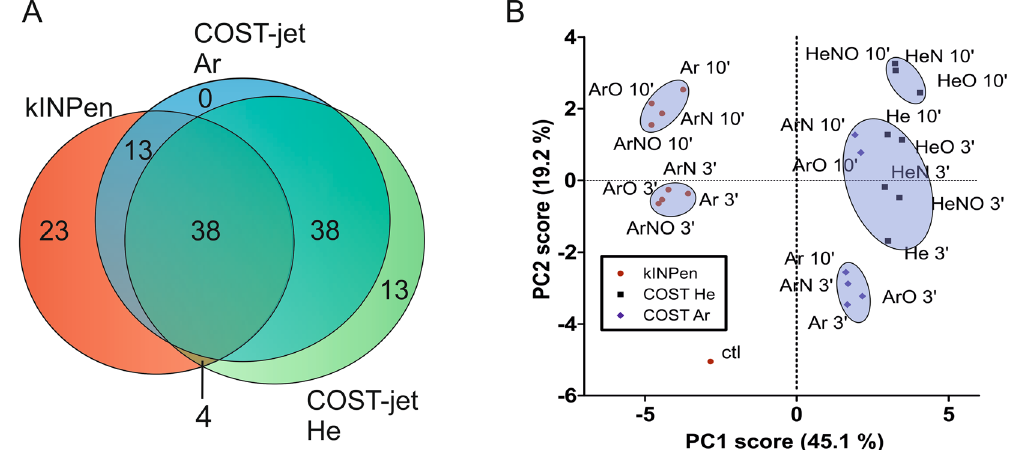
Figure 4. Venn diagram of all detected cysteine modifications ( A ) and corresponding PCA ( B ). Overall, 129 significant products were detected specific to the shown conditions ( A ). The percentages for the principal components (PC) indicate how much spectral differences can be described with PC1 or PC2,